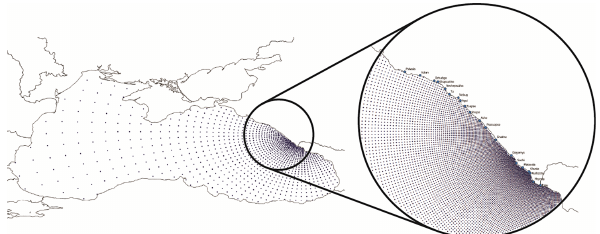
Figure 6. INMOM model domain at the Black Sea (every 15th grid point is shown) (left) and at RCBS (every 4th grid point is shown) with indication of the location of the considered river estu- aries